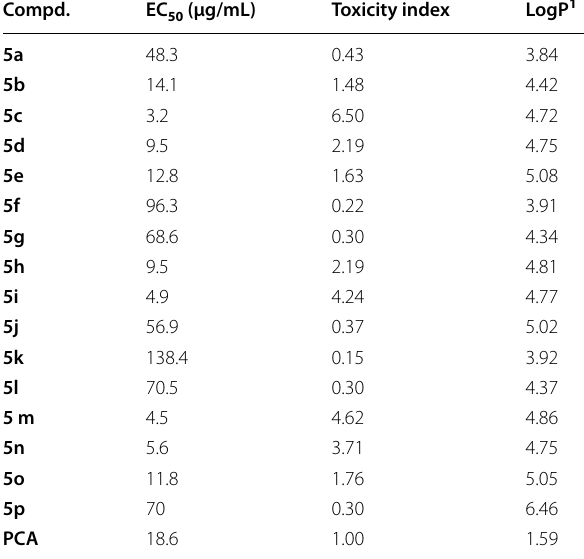
Table 2 EC values against Rhizoctonia solani and octanol– 50 water partition coefficient of conjugates